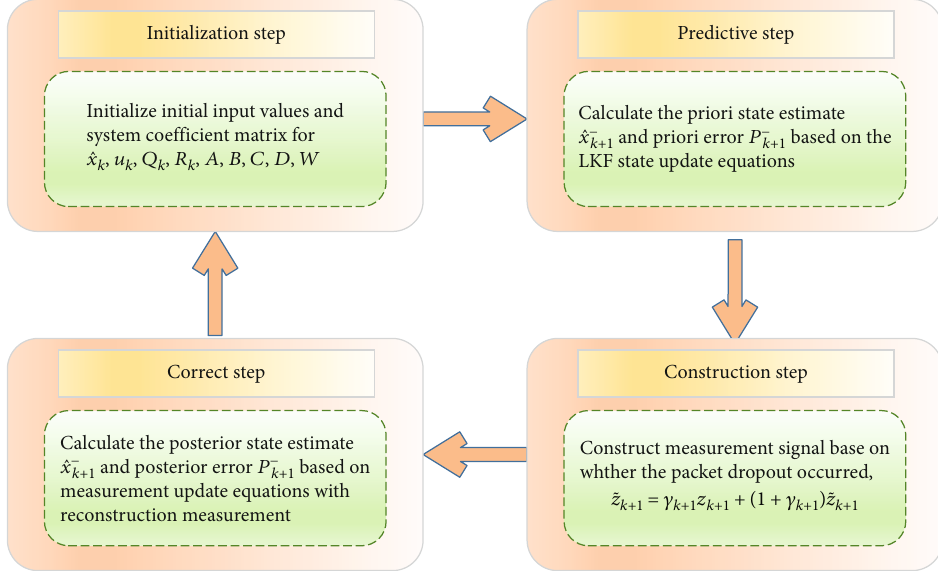
Figure 5: Iteration steps of